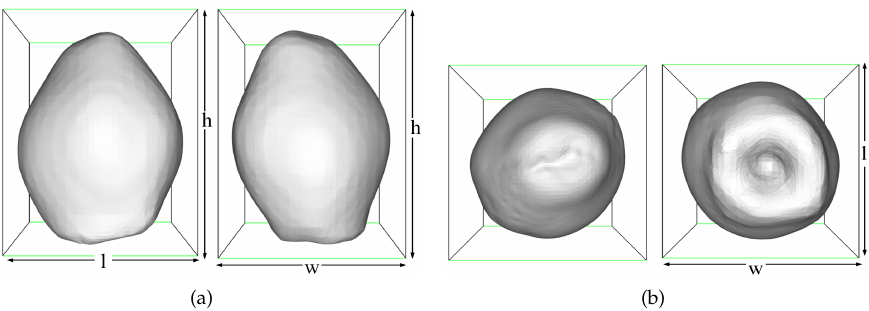
Figure 6. Measurement length, height, and width of the pear model through the bounding-box algorithm. ( a ) 3D model of the pear’s front and lateral surface. ( b ) 3D model of the pear’s top and bottom surface.